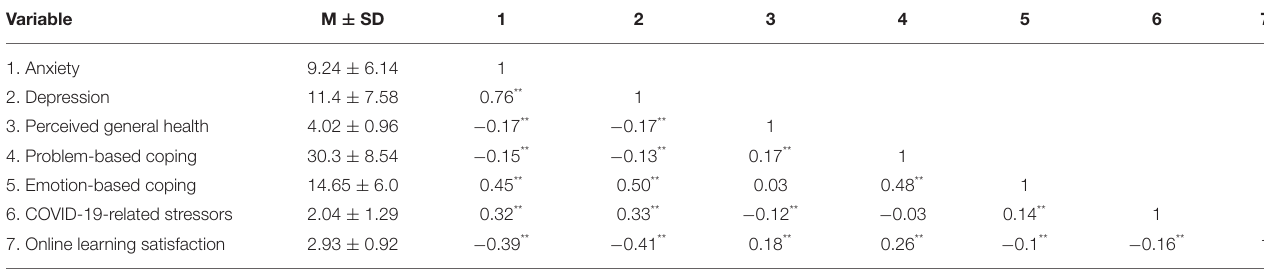
TABLE 1 | Descriptive and correlative analysis of study variables. Variable